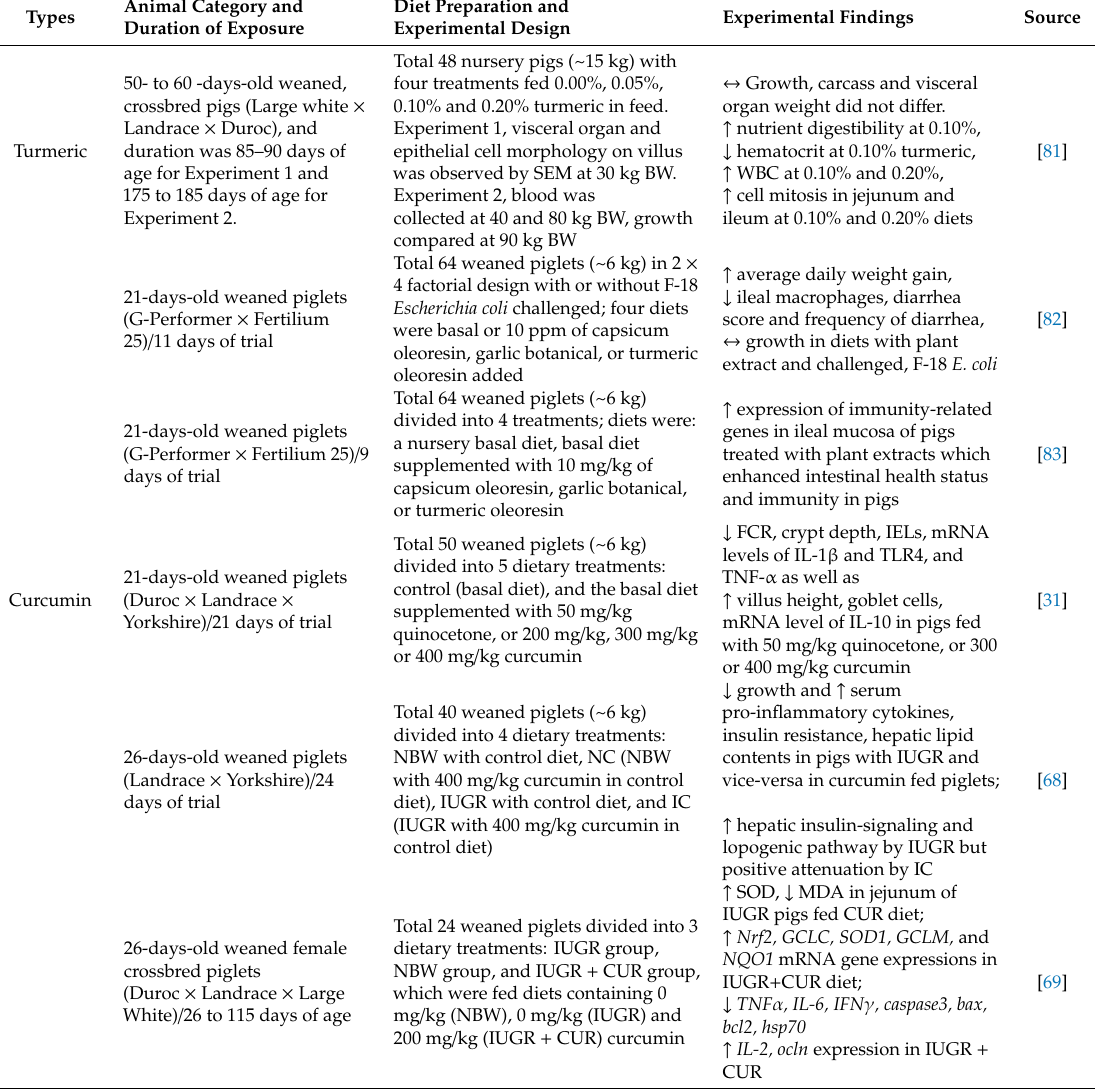
Table 1. E ff ects of dietary turmeric and curcumin in swine